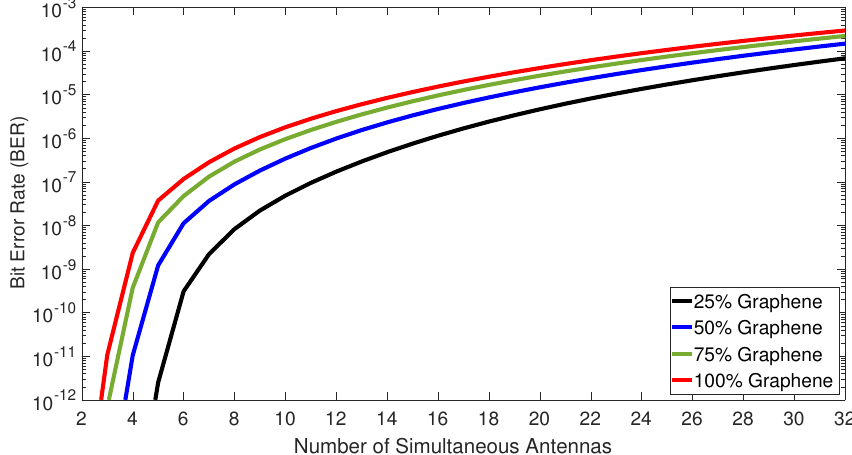
Figure 8. Bit error rate versus the number of simultaneous antennas at the remote unit